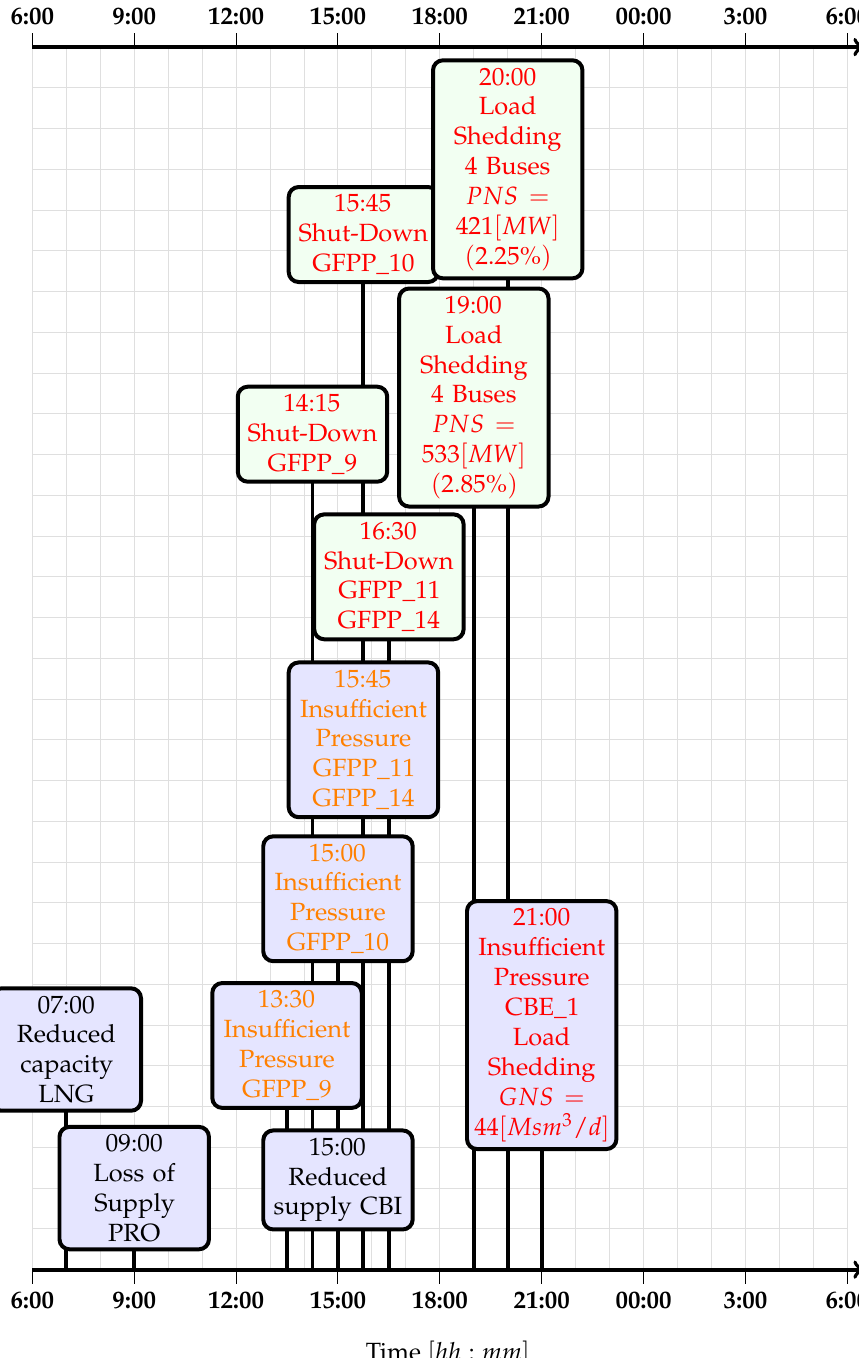
Figure 6. Timing of initial ( black ) and cascading ( orange , red ) events for Scenario 1. Abbreviation PNS stands for power not supplied, while GNS stands for gas not supplied, value in brackets refers to the fraction of not supplied power/gas with respect to total power/gas